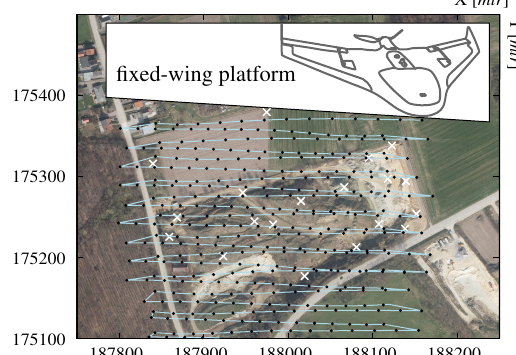
Figure 1: Orthophoto of the open mine, with black dots illustrat- ing the acquisition centers (a total of 360 is used), the ground control points are indicated with a white cross.